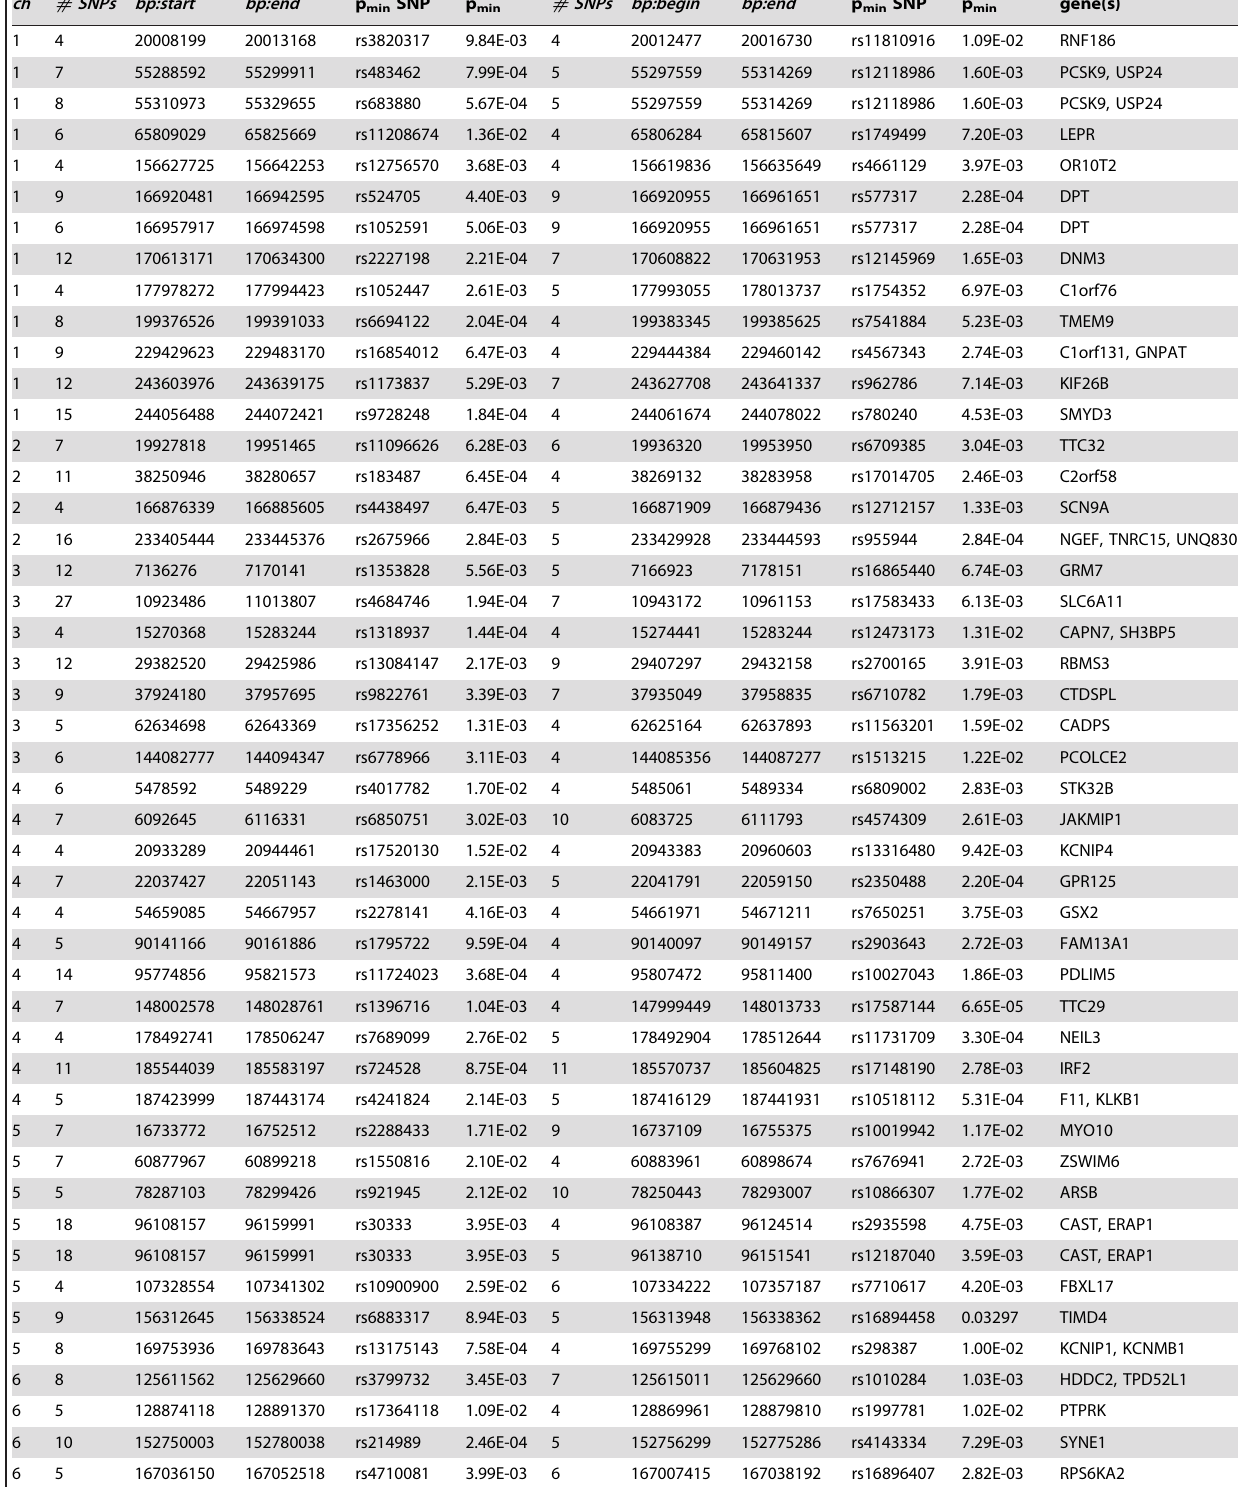
Table 1. Chromosomal regions and genes identified by clusters of SNPs that provide nominally-significant differences between individuals dependent on alcohol (dbGAP alcohol dependent v ctl) or at least one illegal substance (NIDA/MNB drug dependent v ctl) in subjects of European-American